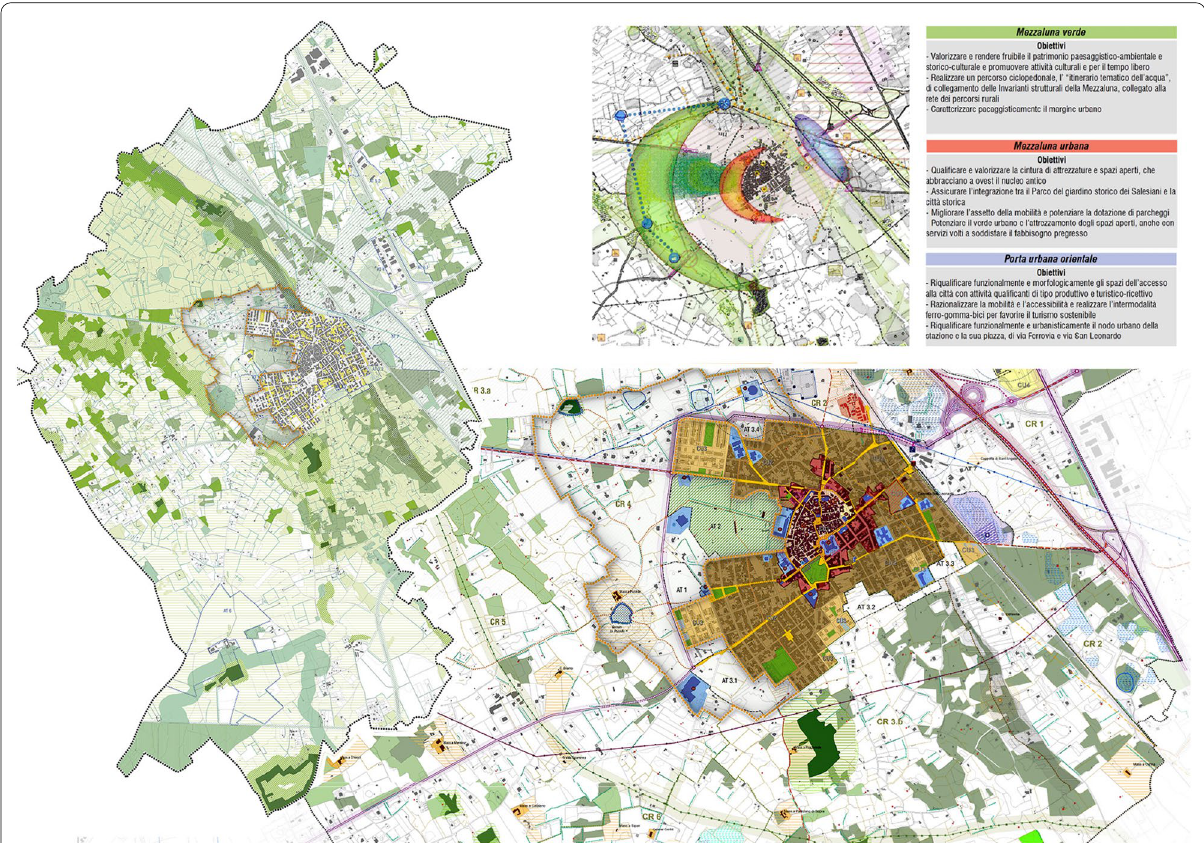
Fig. 6 The City-Country Pact strategy. On the top right the strategic assets of the City-Country Pact. They concern the relationship with the peri-urban countryside (green), the dense city (red) and the urban gateway (blue). The master plan, on the bottom right, shows the relationship between the expansion areas and the valuable elements of the rural area. Source: Municipality of Corigliano d’Otranto, extracts from tables PUG-S 3 (original content scale 1:10,000, north–south oriented) and PUG-S 1.2 (original content scale 1:5000, north–south oriented) of Municipal Urban Plan in conformity with PPTR